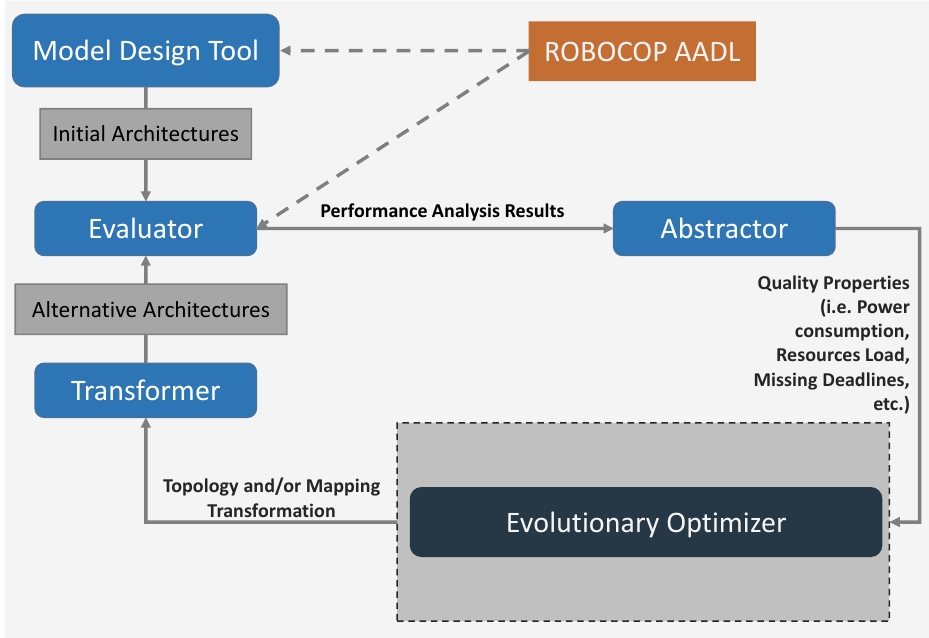
Figure 8. The working scheme of the AQOSA